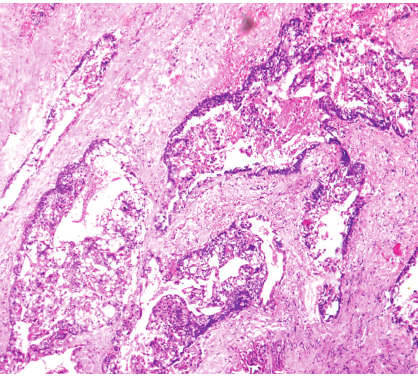
Figure 6: Islands of epithelium comprising mucous cells, epider- moid cells, and intermediate cells (H&E 20x).